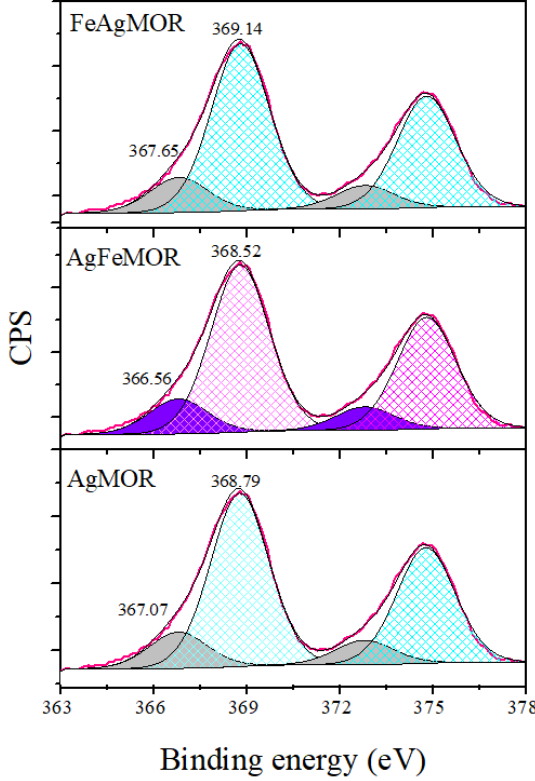
Figure 4. Ag 3d 5/2 photoelectron spectra of the studied Figure 4. ( a ) Ag 3d 5/2 and ( b ) Fe 2p 3/2 photoelectron spectra of the studied samples. Table 3. Ag 3d 5/2 binding energy (eV) of deconvoluted peaks.